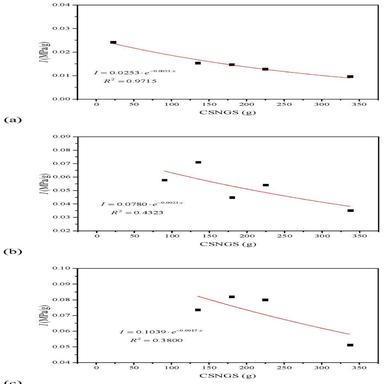
Fitting of unit additional strength coefficient of CSNGS pozzolanic reaction, (a) 7 d (b) 28 d (c) 90 d.